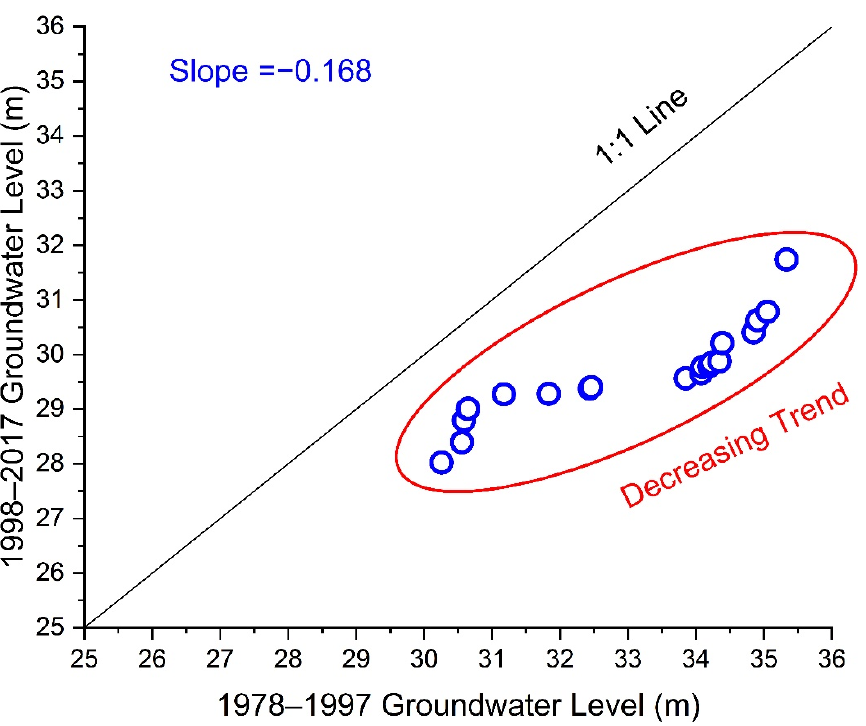
Figure 7. Results of the innovative trend analysis of the annual mean groundwater level in the Gnangara region.